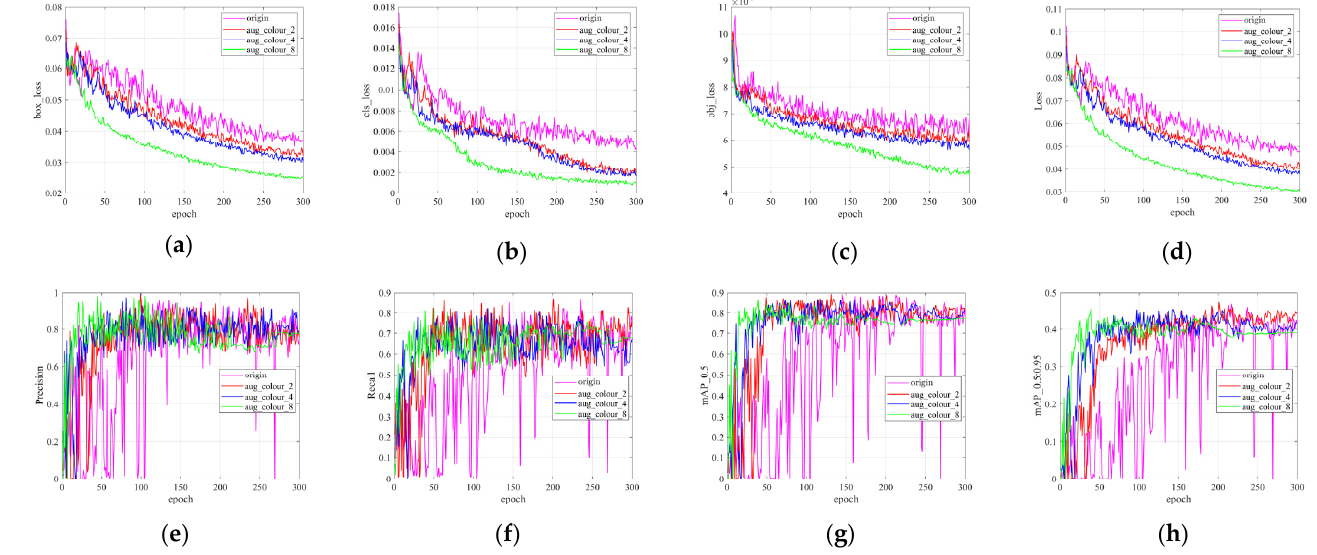
Figure 10. The training details of radar signal imaging augmentation strategy: ( a ) box_loss ; ( b ) cls_loss ; ( c ) obj_loss ; ( d ) total of three loss; ( e ) precision; ( f ) recall; ( g ) mAP_0.5; ( h ) mAP_0.5:0.95.